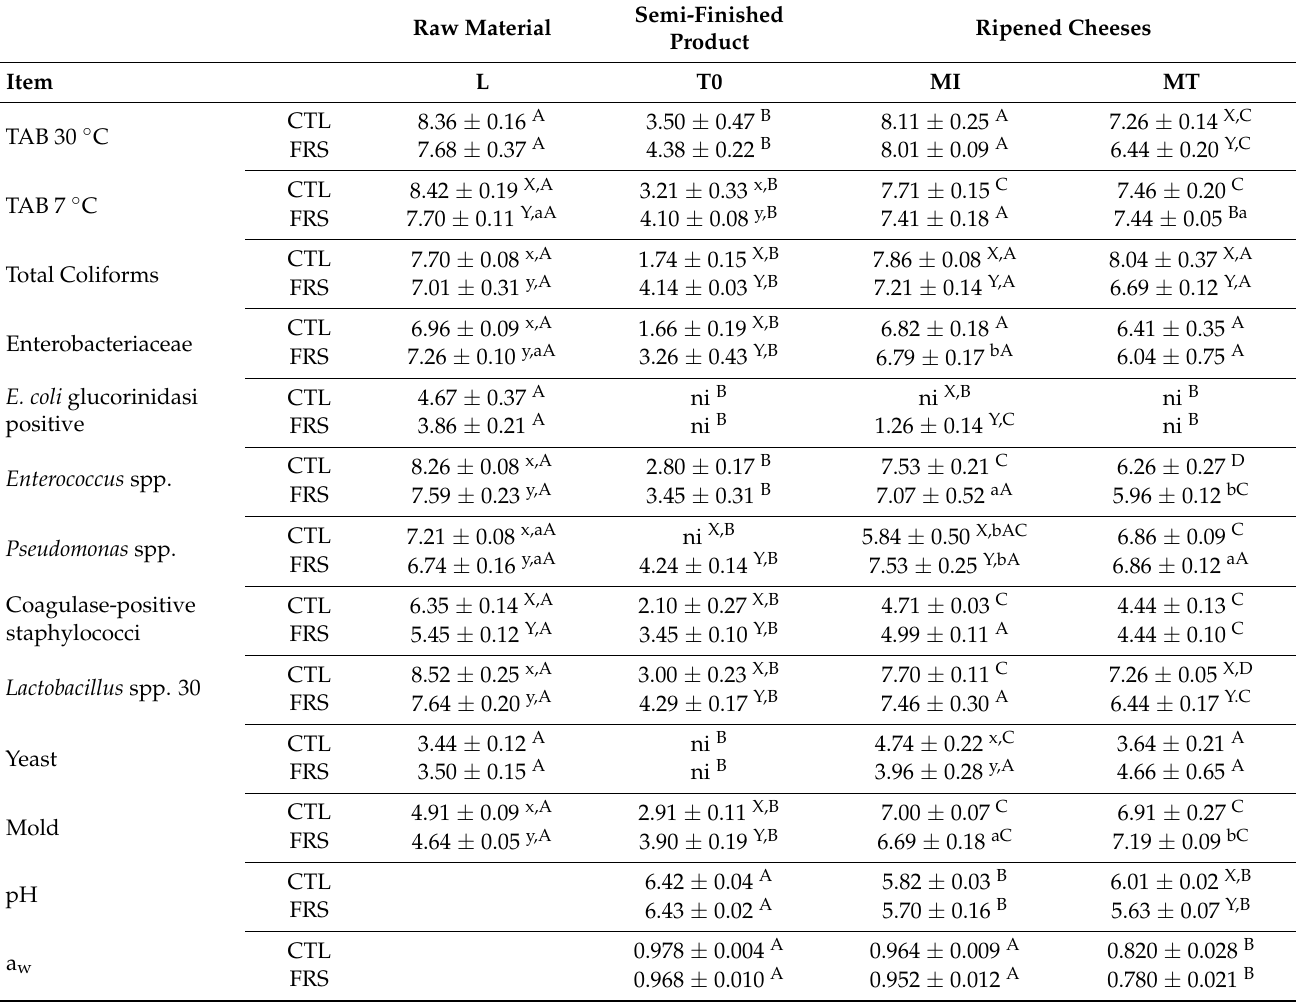
Table 9. Microbiological (Log (cfu/g)) and physicochemical results of dry ricotta buffalo